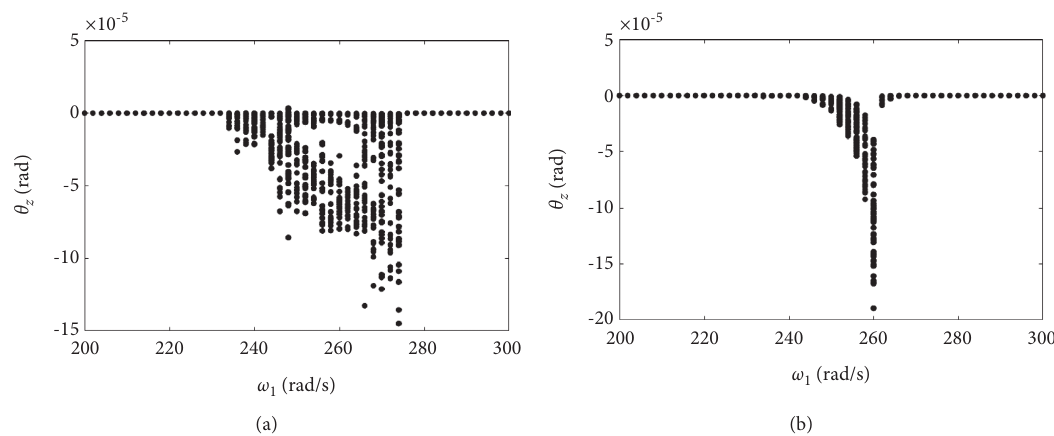
Figure 21: Bifurcation diagrams for the torsional vibration of disk 4 with rub-impact. (a) Level flight. (b) Hovering